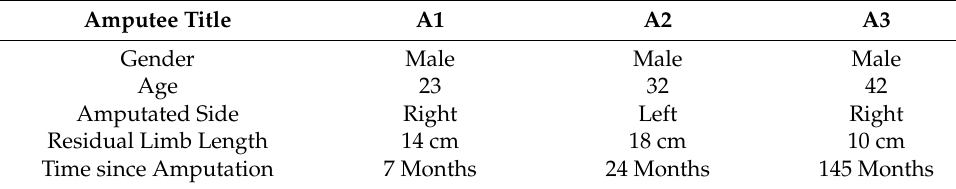
Table 1. Demographic characteristics of amputee subjects.